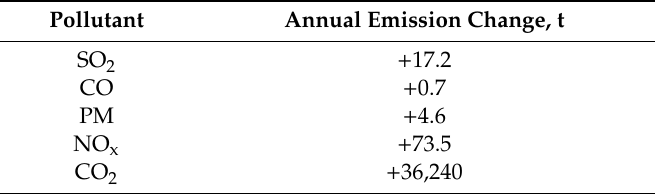
Table 11. Annual pollutant balance in the refinery for Scenario A.